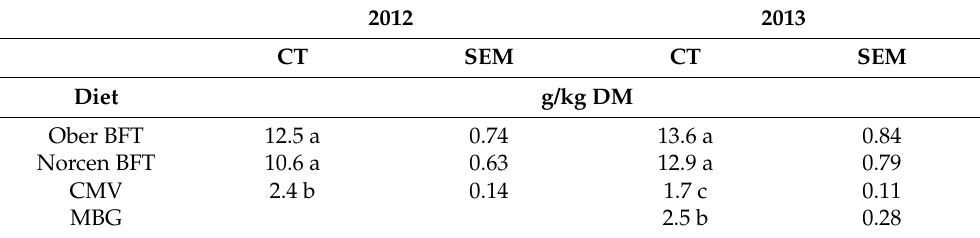
Table 3. LSMEANS of season-long condensed tannin (CT) concentrations, measured in 2012 and